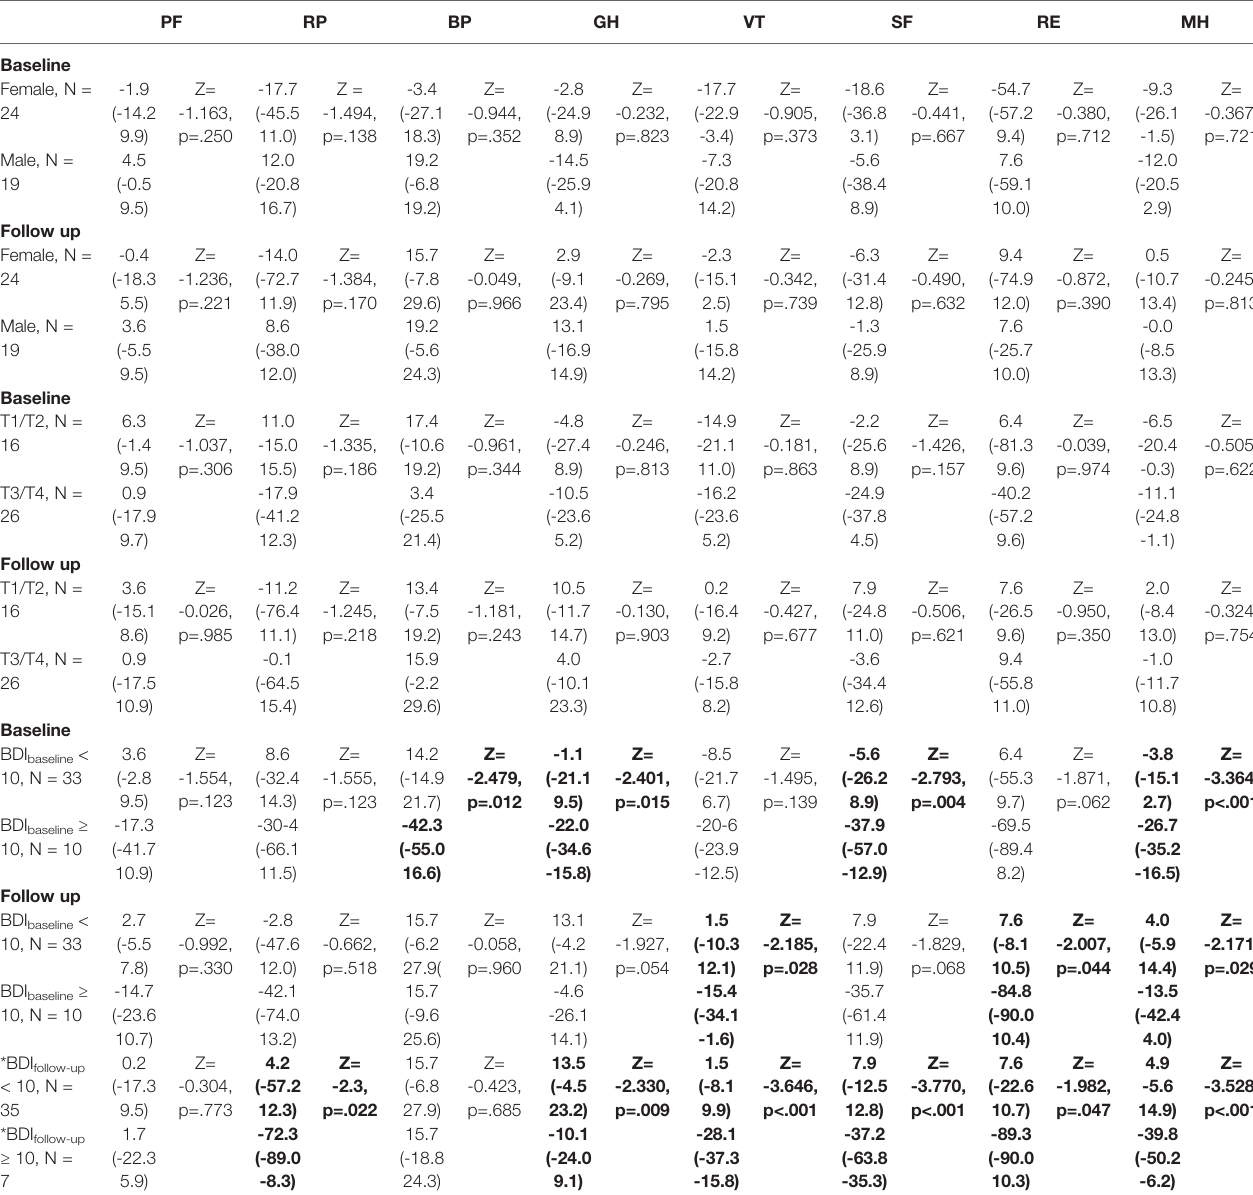
TABLE 3 | SF-36 subgroup analysis, median (25 th 75 th percentile) and results of Mann-Whitney-U test are given for each subscore of the SF-36. PF RP BP GH